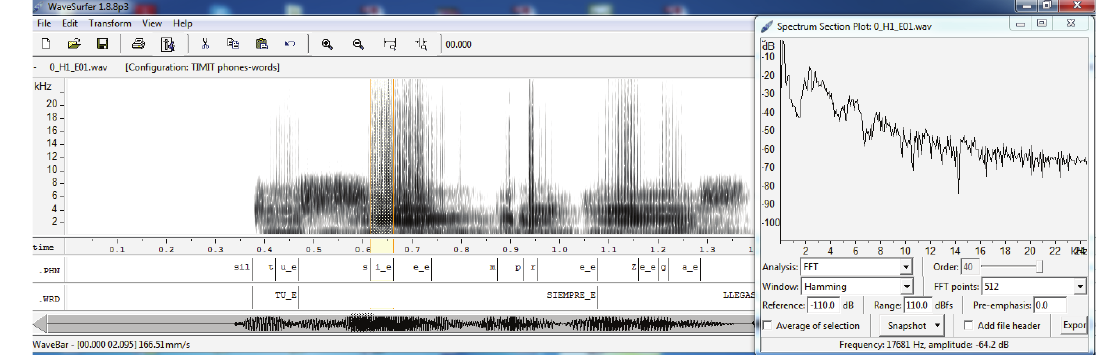
Figure 1: Spectrum section plot for the vowel “i e” (/i/ with